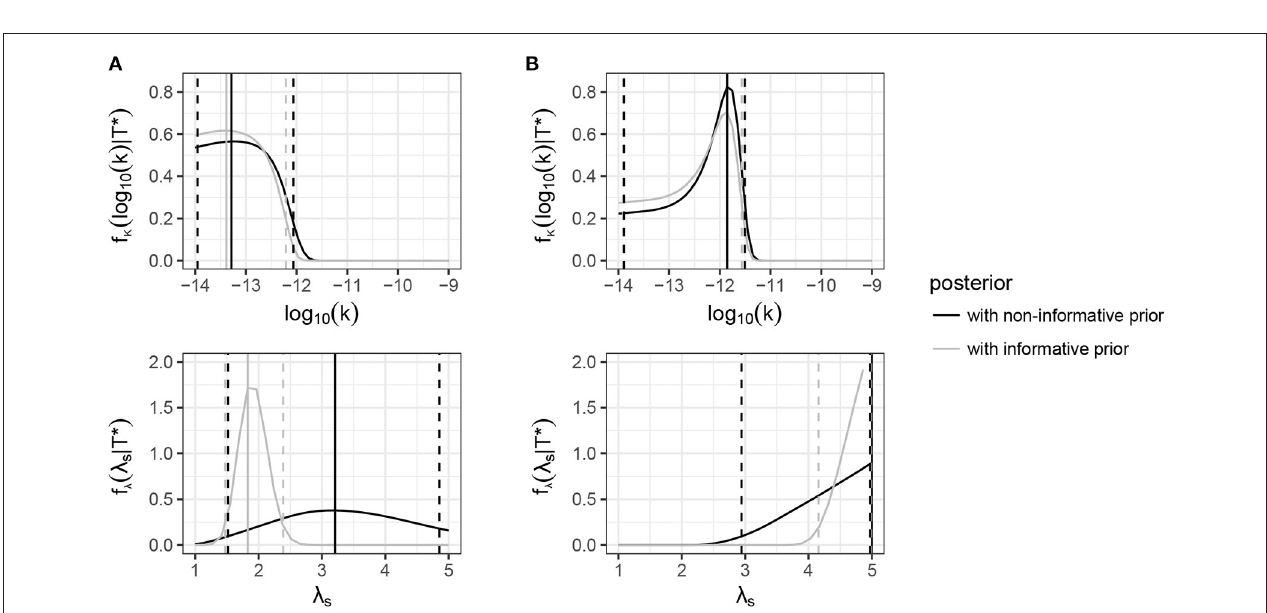
FIGURE 7 | Normalized likelihood functions as a function of advective effective parameter α e and conductive effective parameter κ e , (A,B) refer to the two LOMOS-mini measurement datasets presented in Figure 6 , corresponding to an infiltration and an exfiltration case study respectively. In each panel, values are normalized so that the same color scale can be applied, the x-axis is plotted on a log-scale. For grayed-out combinations of α e and κ e , numerical simulations have not converged within the allocated time (15 min) and no likelihood value can be computed. By comparing with the analytical study results ( Figure 3 ), point (A) seems to undergo a conductive regime where high likelihoods are restricted within a narrow interval of κ e and high likelihood are bounded by a maximum value for α e , while point (B) seems to undergo a transition regime where both κ e and α e can be well-characterized from LOMOS-mini measurements.